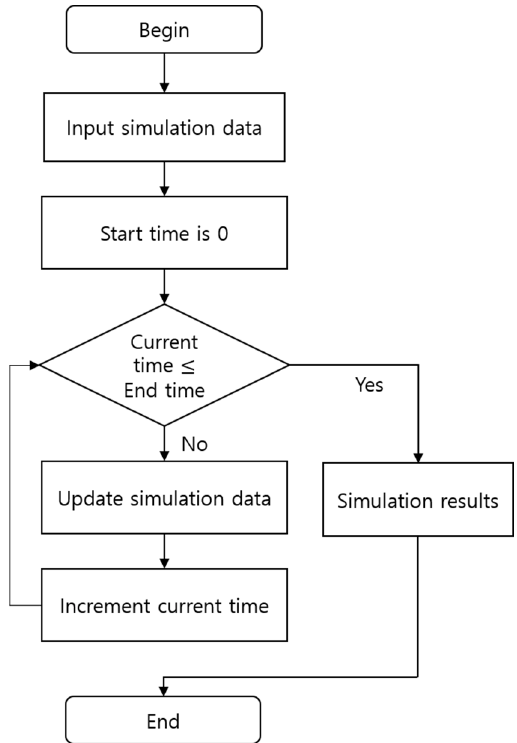
Figure 3. Simulation modeling of virtualized port-container terminal.